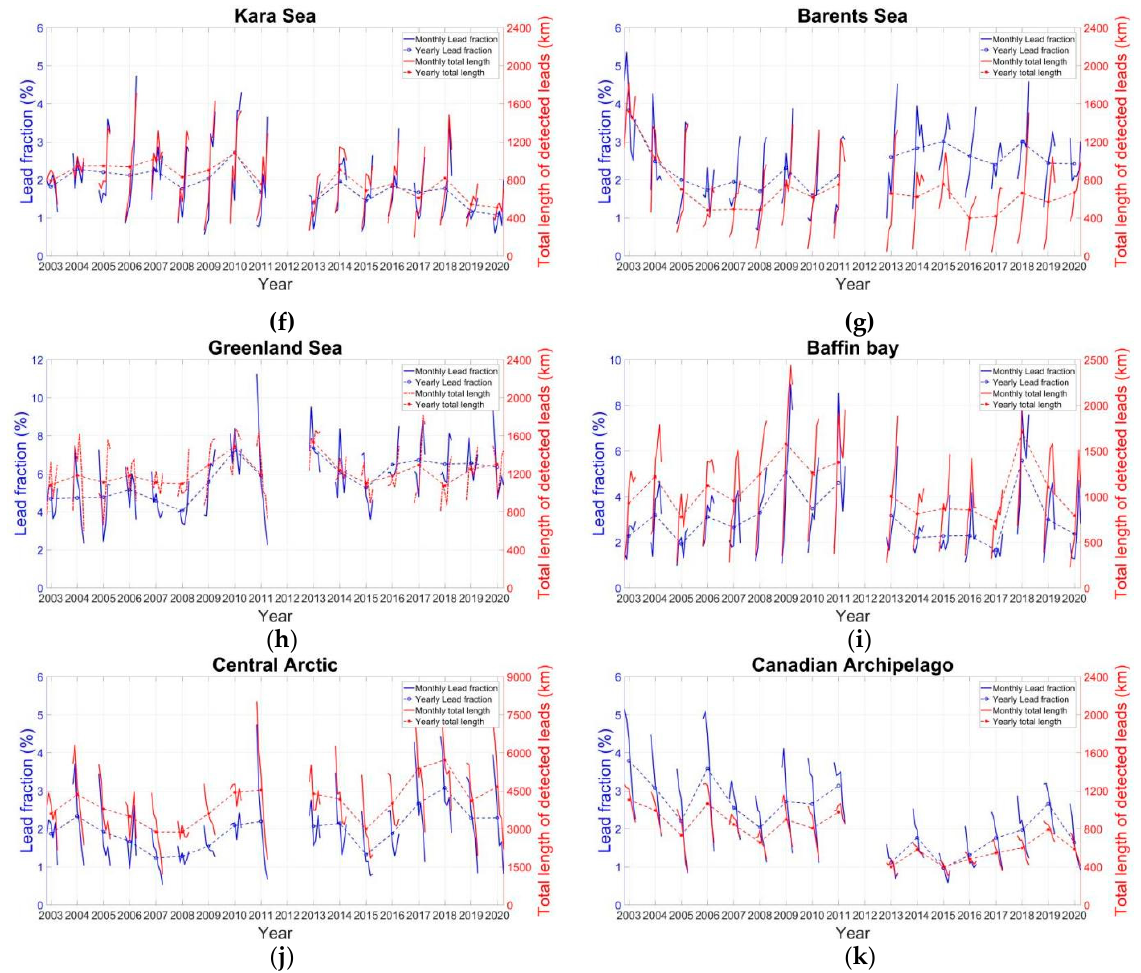
Figure 6. Evolution of sea ice lead fraction (blue color) and total length of sea ice leads (red color) in km in different regions in the AMSR family data. Solid lines denote monthly mean values. Dashed lines with circles denote annual mean values. ( a ) Whole Arctic, ( b ) Beaufort Sea, ( c ) Chukchi Sea, ( d ) East Siberian Sea, ( e ) Laptev Sea, ( f ) Kara Sea, ( g ) Barents Sea, ( h ) Greenland Sea, ( i ) Baffin Bay, ( j ) central Arctic, and ( k ) Canadian Archipelago.